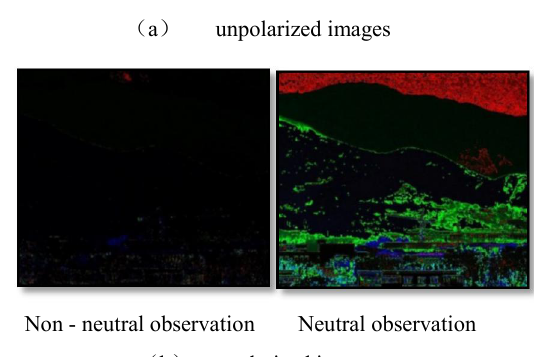
Figure 8. Comparison of polarization parameters for neutral point imaging and non-neutral point imaging (Beijing Summer Palace) Figure 8 shows the polarization parameters for the neutral point imaging and the non-neutral point imaging. The left image is a non-neutral view of the image, the right image is a neutral observation of the image. Figure 8. (a) images with no polarizing film, the visibility of the atmosphere is high, both in the neutral area observation or in the non-neutral area observation, the image is relatively clear; neutral observation of the image (right) Reflected on the terrain information than the non-neutral observation of the image (right) to reflect the information to be